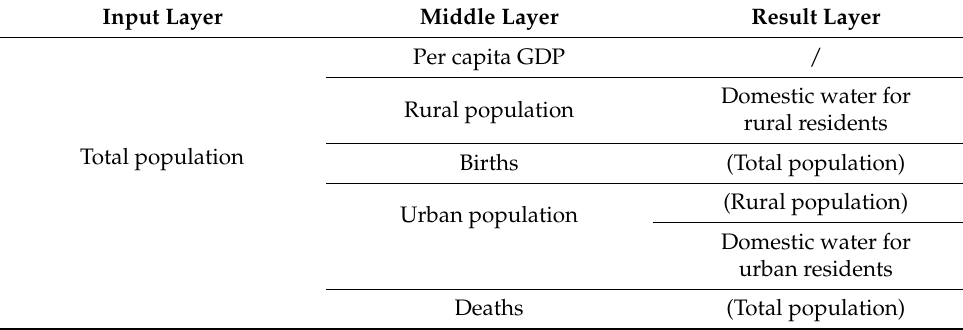
Table 2. Result hierarchy for the total